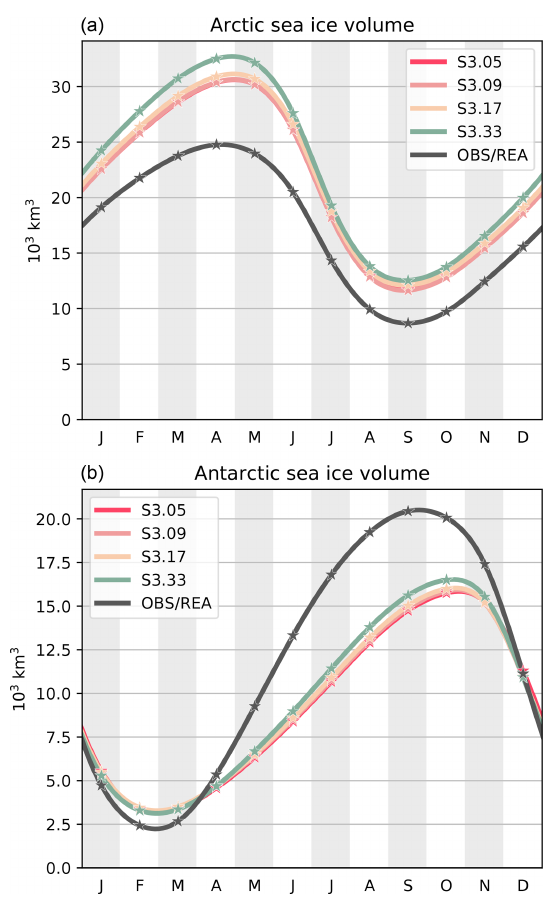
Figure 9. Mean seasonal cycles of Arctic (a) and Antarctic (b) sea ice volumes, over 1995–2014, in the third set of sensitivity ex- periments. Also shown are the Arctic and Antarctic ice volumes derived from the PIOMAS and GIOMAS reanalyses, respectively (Schweiger et al., 2011; Zhang and Rothrock, 2003). The stars show the monthly data and the curves are cubic interpolations between the data